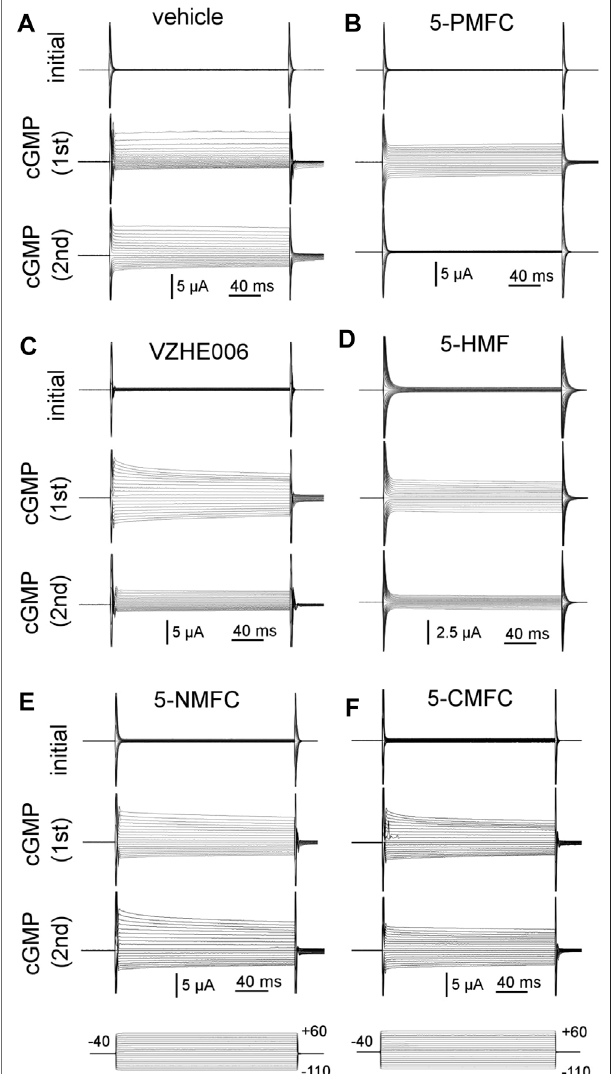
FIGURE 1 | Electrophysiological recordings illustrating the effects of furan derivatives on the 8CPT-cGMP-activated AQP1 ion conductance. Representative sets of traces recorded by two-electrode voltage clamp of AQP1-expressing oocytes showing the initial conductance; the response induced by the fi rst application of membrane-permeable 8CPT- cGMP; and the response to a second application of cGMP after 2 h of incubation in isotonic saline containing (A) equivalent DMSO vehicle; and 0.5 mM of (B) 5-PMFC; (C) VZHE006; (D) 5-HMF; (E) 5-NMFC; (F)